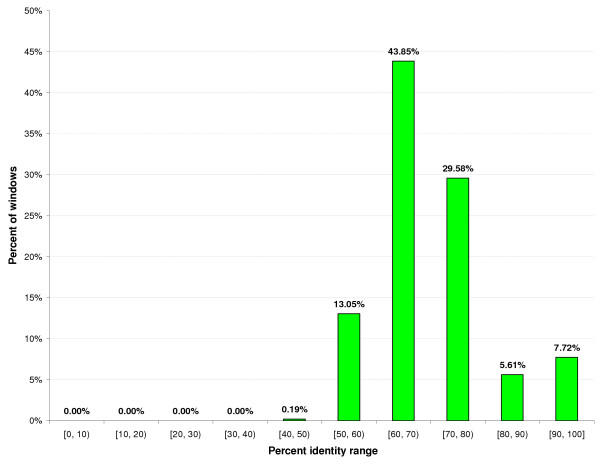
Distribution of scanning window percent identities in the WuBLASTn whole genome ncRNA screen. Histogram showing the distribution of percent identities of 90,404 genomic windows (size 150 alignment columns, scanning step size 75 alignment columns), generated from the WuBLASTn whole genome alignment of E. coli and S. typhi.